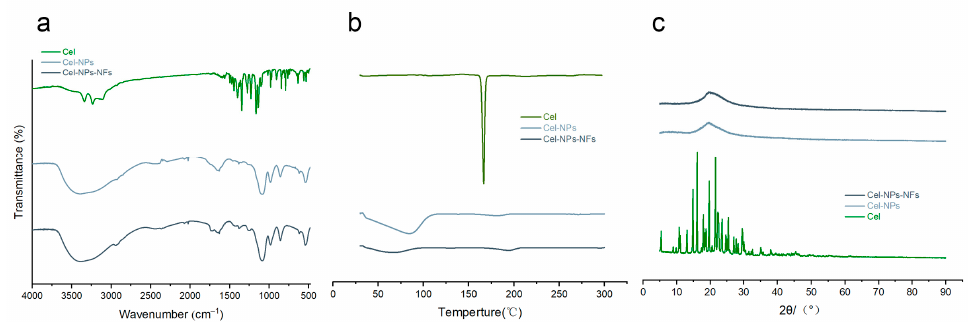
Figure 4. Discussion on the interaction mode of drugs and carriers IR, DSC, and X-RD; ( a ) Infrared characteristic map; ( b ) DSC curve; ( c ) X-ray diffraction pattern. (Cel, Cel-NPs and Table 1. Drug loading and encapsulation efficiency of different preparations.